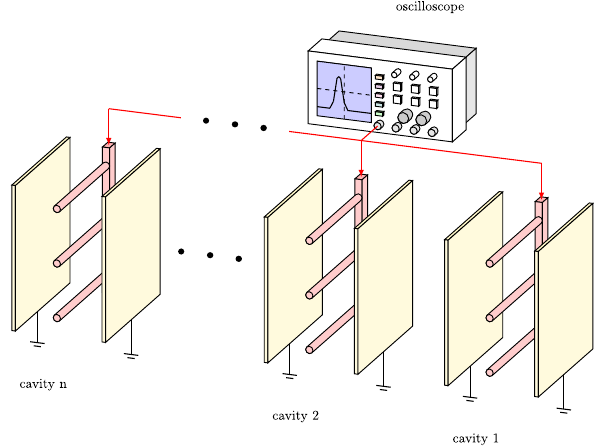
Fig. 1 Parallel plate cavity design with pillar-like features along the mid-plane – the dynamic vacuum model predicts that the scope will measure a small but non-zero transient voltage pulse from the pillars once connected to the cavities as shown. The anticipated geometry of each cavity is approximately 4 µ m wide with each plate measuring 40 µ m by 40 µ m. The pillars are expected to be approximately 1 µ m in diameter